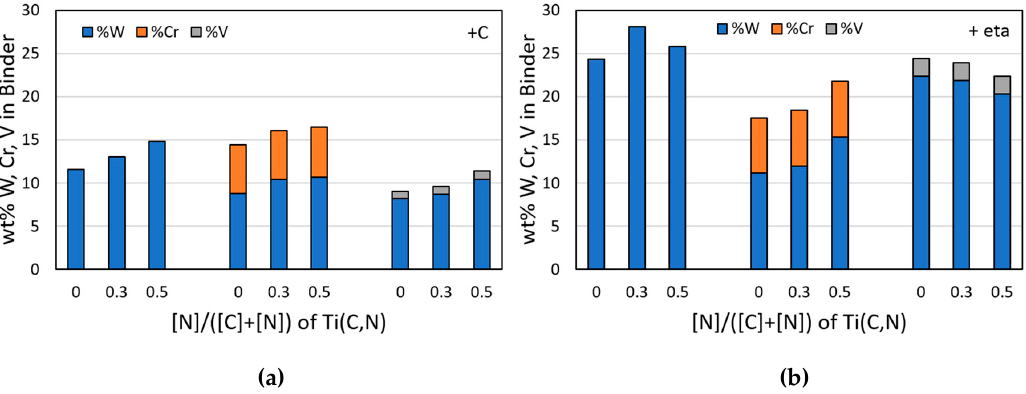
Figure 2. Binder phase solubility of W, Cr and V from Co-rich model alloys as a function of the nitrogen content [N]/([C]+[N]) of Ti-containing MC/M(C,N) phases in the starting formulation. ( a ) with free C, ( b ) with the eta phase.